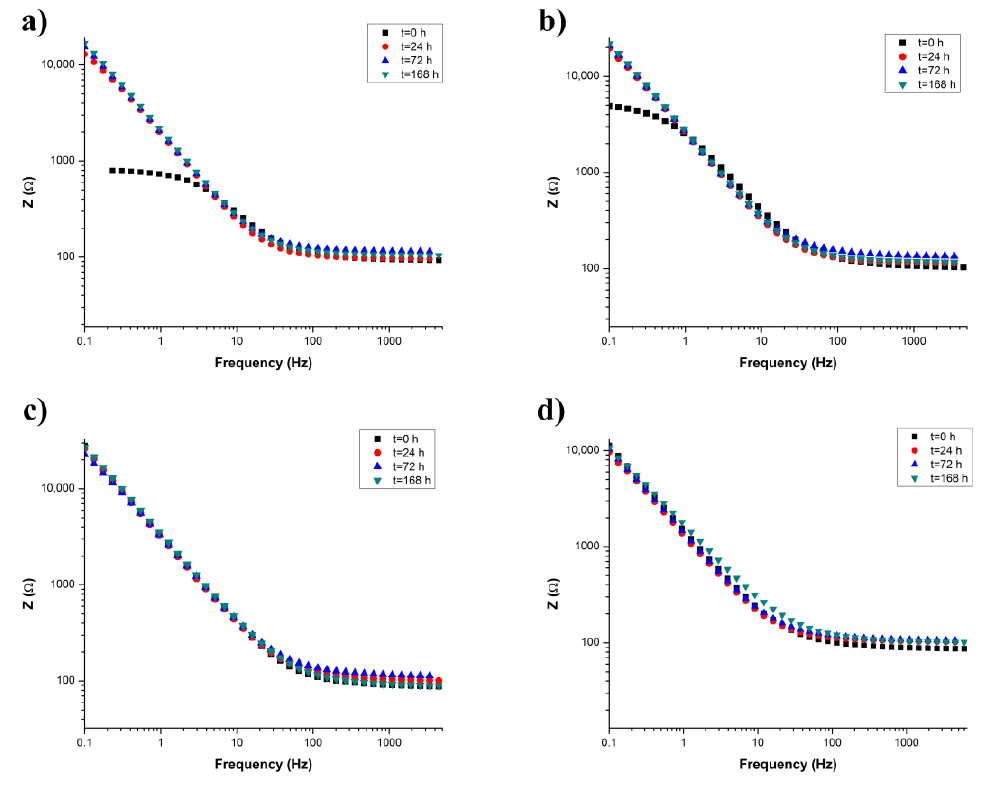
Figure 9. Bode Modulus diagrams for ( a ) Samples 1, ( b ) 2, ( c ) 3, and ( d ) 4.